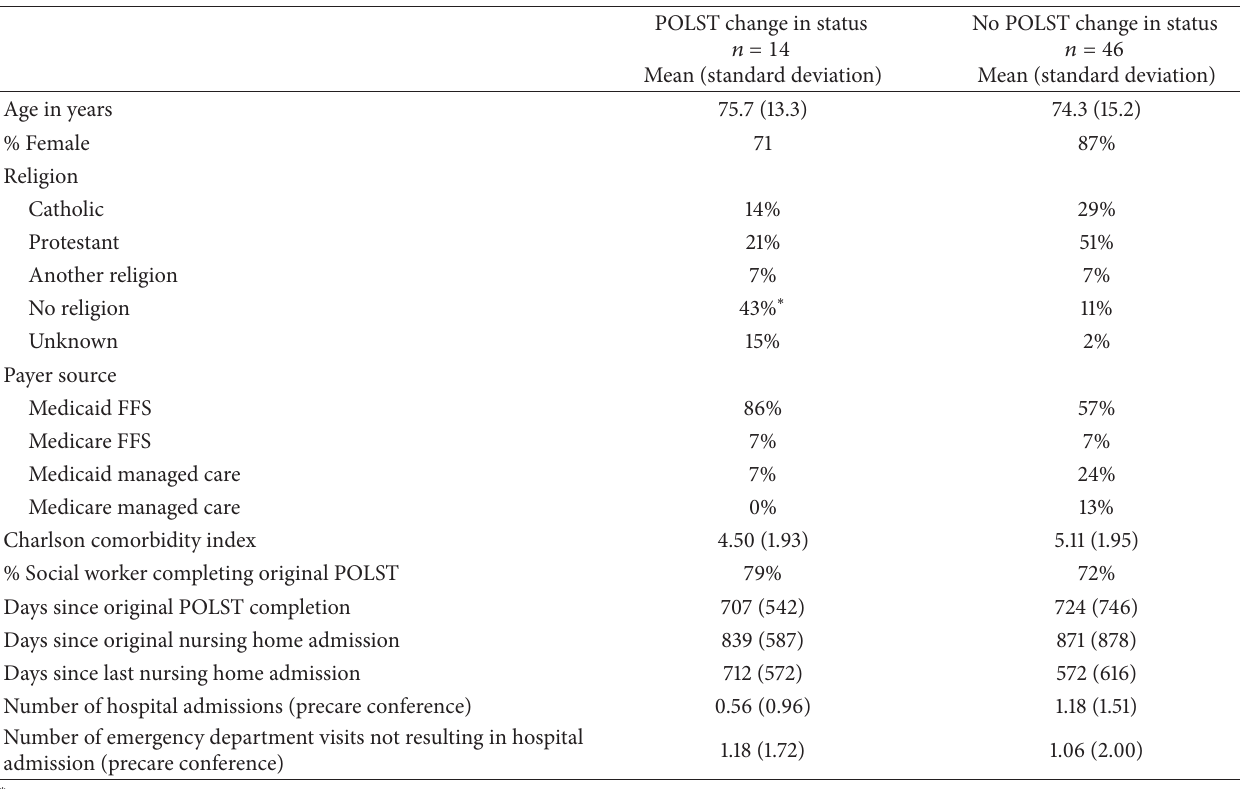
Table 2: Demographic and health care utilization characteristics among nursing home residents who had CRNP participate in care conference, by POLST change in status versus no POLST change in status.